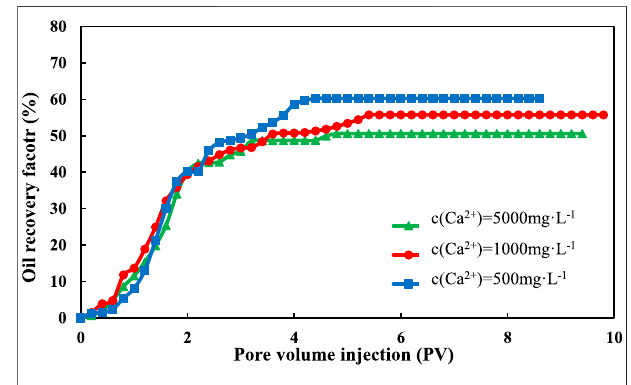
FIGURE 7 | Oil recovery of kaolinite sand packs of different salinity of CaCl 2